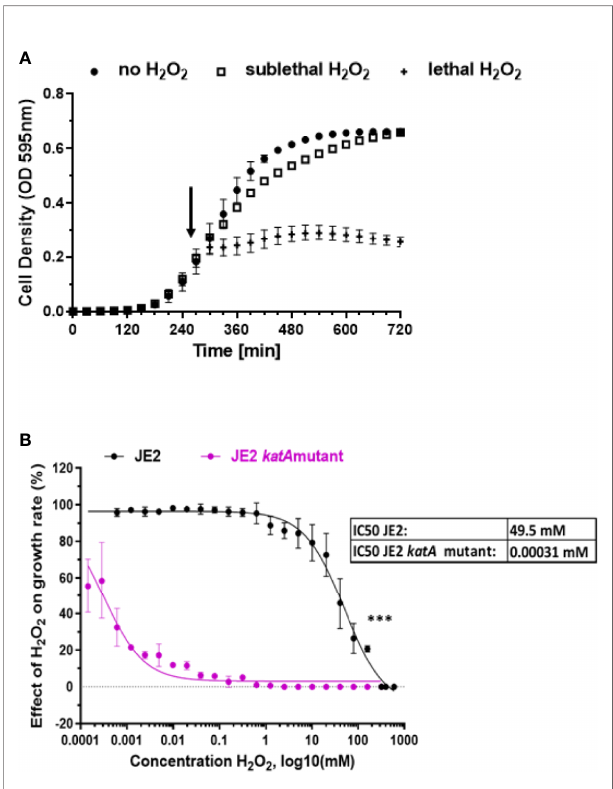
FIGURE 1 | Effect of H 2 O 2 on S. aureus growth. (A) S. aureus wild-type JE2 strain growth in absence of H 2 O 2 ( ● ) and in the presence of two H 2 O 2 selected concentrations: sublethal (20mM) ( □ ) or lethal (160 mM) (+). H 2 O 2 was added in the early exponential phase, as indicated by an arrow. (B) Effect of 22 different concentrations of H 2 O 2 on wild-type S. aureus JE2 strain and its corresponding katA mutant and compared to growth in the absence of H 2 O 2 . Normalized values were expressed as percent of growth in the absence of H 2 O 2 on the same experiment. Results represent the mean ± SD of three independent experiments (four replicates for each H 2 O 2 concentration). A nonlinear regression model was applied to estimate the IC 50 . ***p <